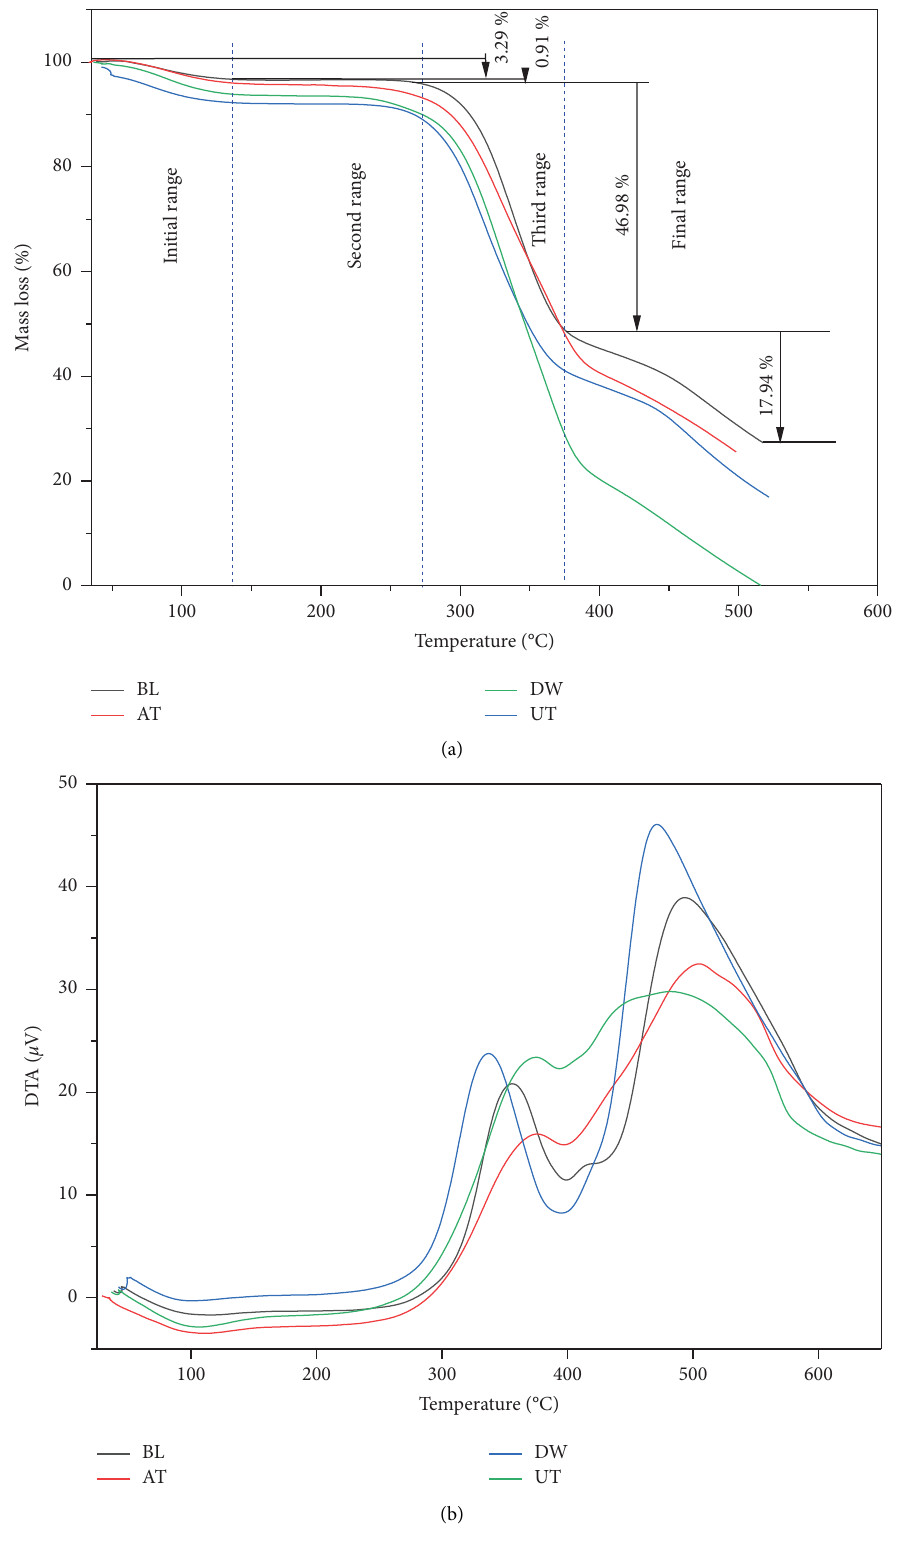
Figure 7: (a) TGA and (b) DTA curves of UT, DW, AT, and BL